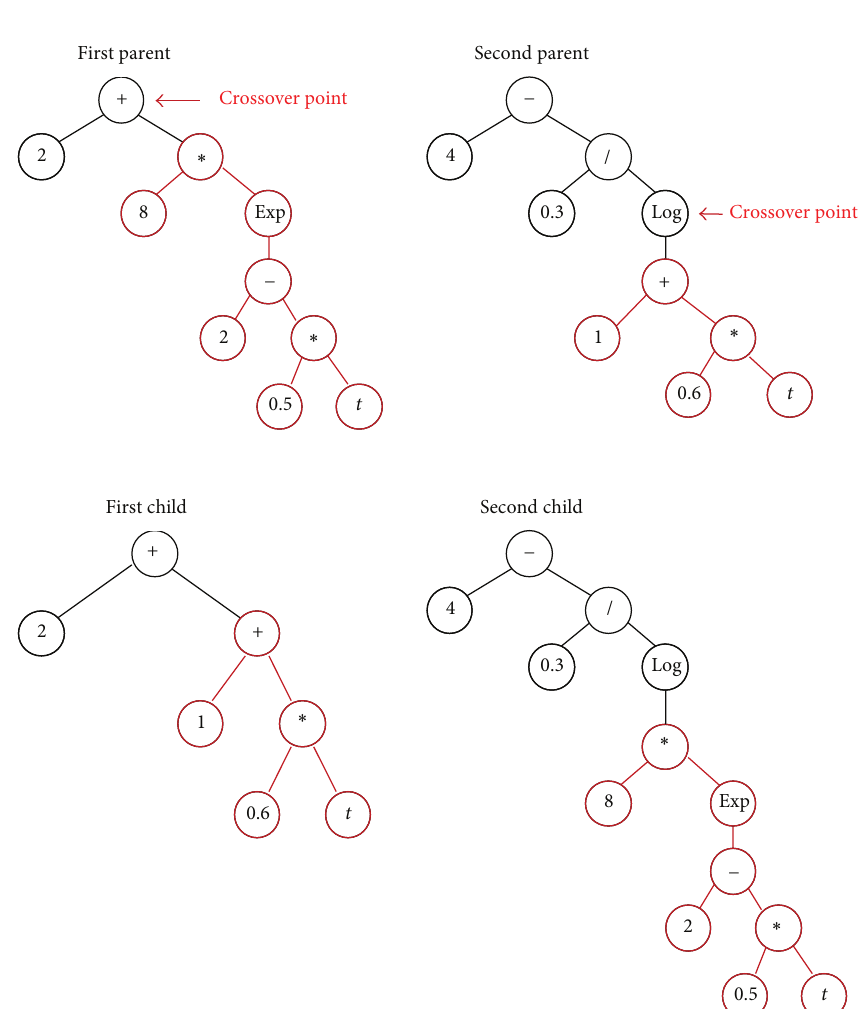
Figure 6: Crossover of the modified-hybrid Genetic Programming method (parse tree representation).